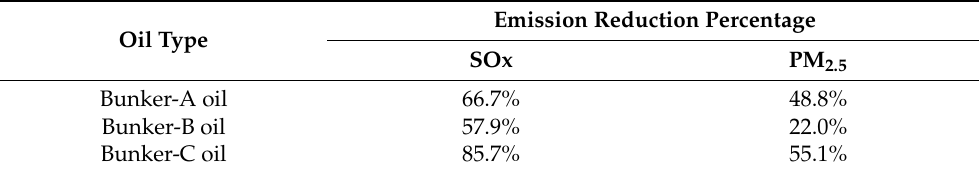
Table 5. Sulfur content for each oil type and reduction ratios of SOx and PM 2.5 emissions in CAPSS2016 when applying